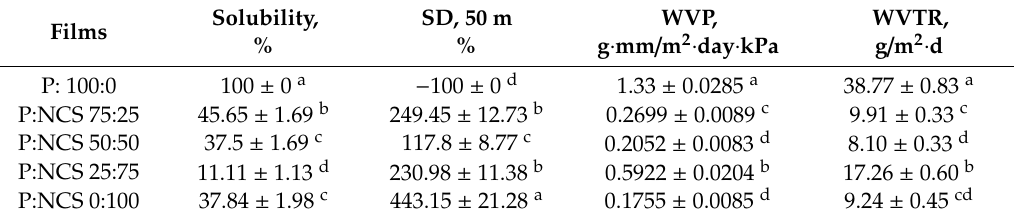
Table 3. Hydration properties of the